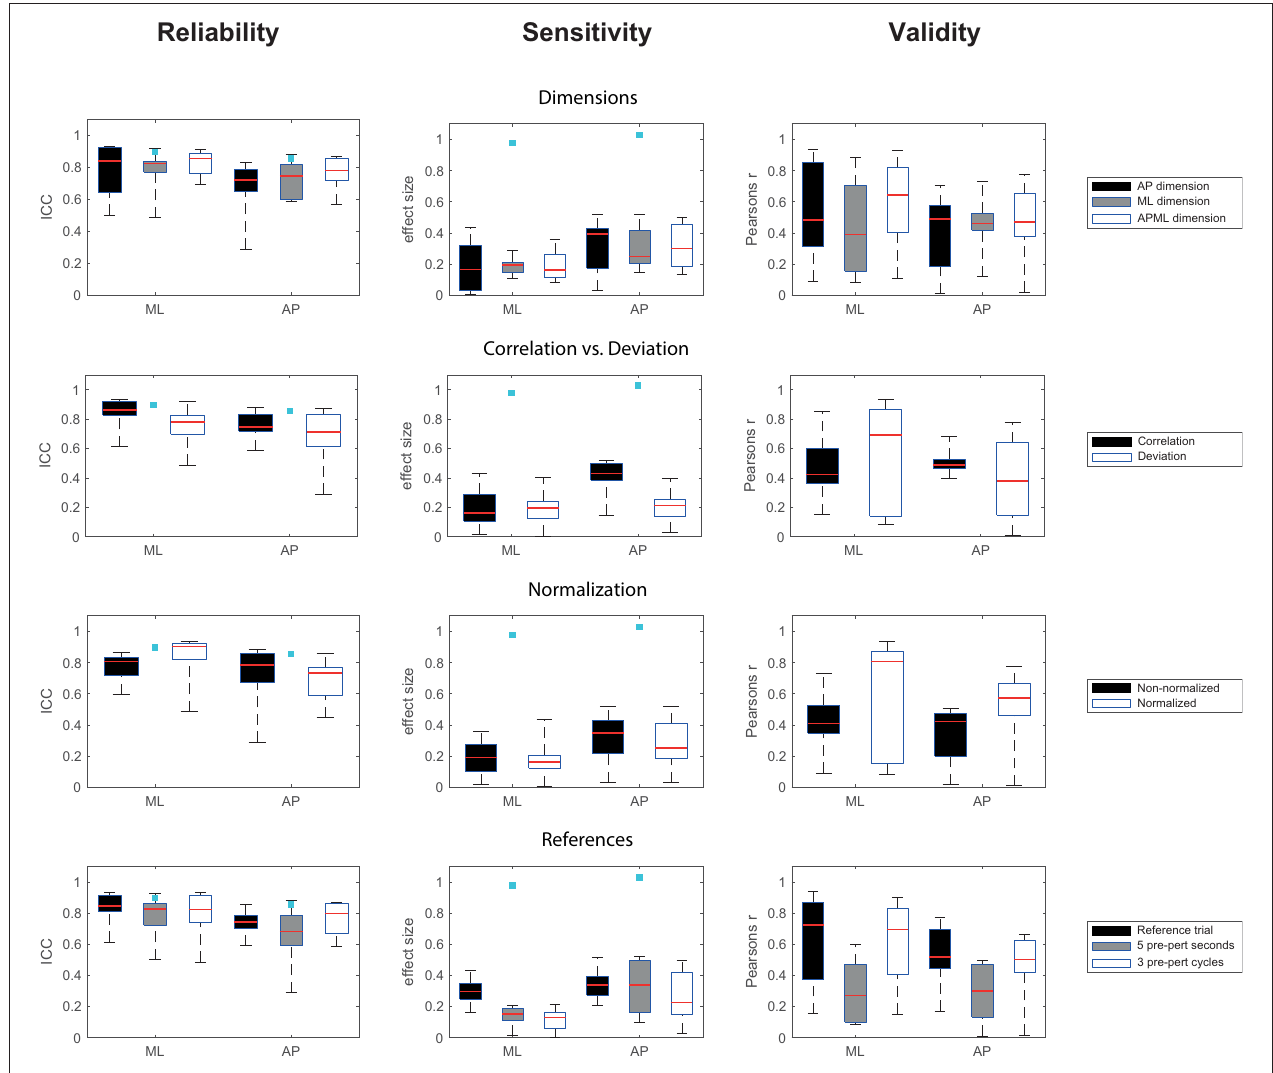
FIGURE 3 | Boxplots of outcomes for different methodological choices of QRP implementations, x-axis: ML, medio-lateral perturbation; AP, anterior-posterior perturbation, light blue squares indicate the results of the trunk velocity deviation measure. missing gait events and our data suggests that normalizing